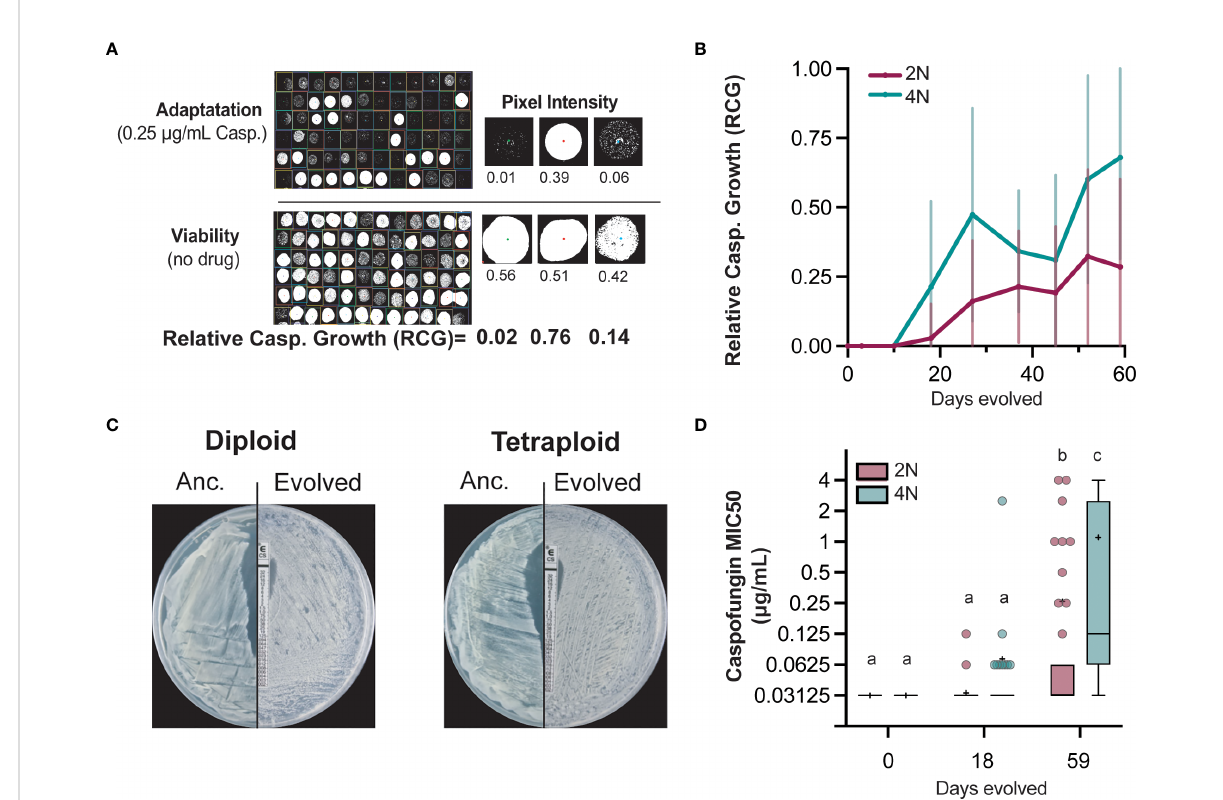
FIGURE 1 Diploid and tetraploid C. albicans evolution under caspofungin selection. (A) Relative caspofungin growth (RCG) was determined periodically over the course of experimental evolution. Replicate lines were spotted on no-drug and 0.25 m g/mL caspofungin plates and photographed after 24 hrs. Pixel intensity was measured and the ratio of caspofungin growth to total viable growth calculated. Representative images with calculated RCG are tetraploid lines 68, 69, and 70 from Day45. (B) Average RCG for diploid (maroon; n=65) and tetraploid (teal; n=72) replicate lines on days 0, 3, 10, 18, 27, 37, 45, 52, 59. Error bars represent +/- 1SD. (C) Representative caspofungin MIC e-tests of ancestral and day 59 evolved diploid (line 64) and tetraploid (line 35). (D) Caspofungin liquid MIC of diploid- and tetraploid-evolved lines for day 0, day 18, and day 59. Data is displayed as Tukey- box-and-whisker plots. The mean is indicated by (+) and circles indicate outliers. Statistical differences among ploidy group and timepoints were tested using Kruskal-Wallis test with Dunn ’ s post hoc multiple-comparison testing. Groups that share letters are not signi fi cantly different, whereas those with differing letters are statistically